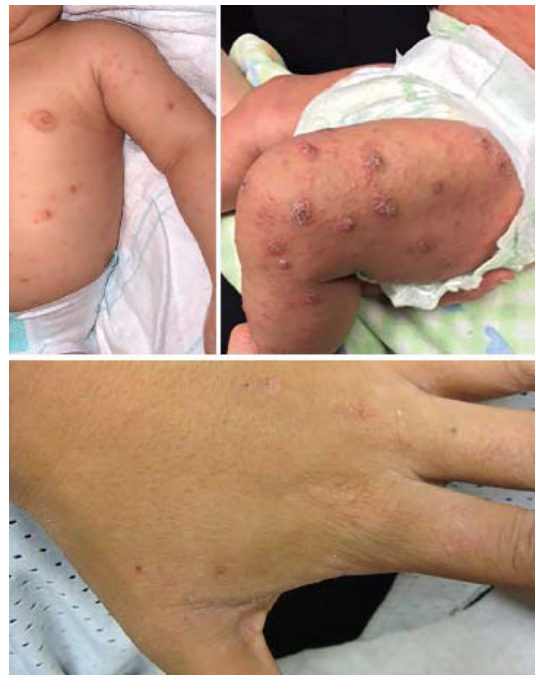
Figure 20. Scabies.